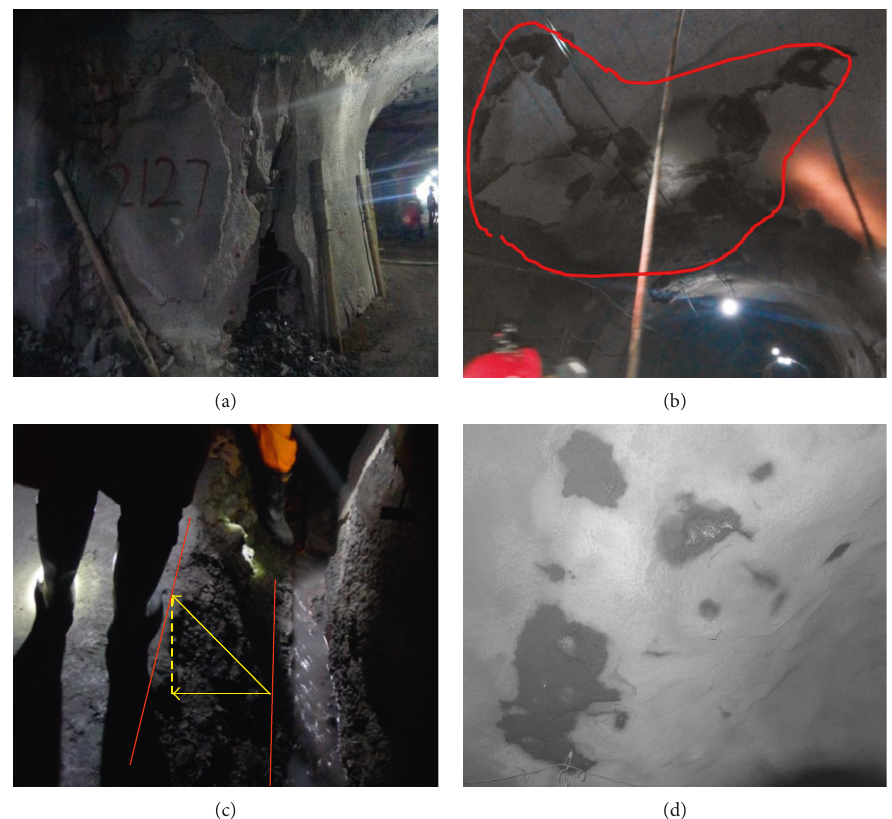
Figure 2: Different destruction modes of expansive soft rock roadway. (a) Pillar failure, (b) roof falling, (c) roadway floor heave, and (d) water seepage deformation.